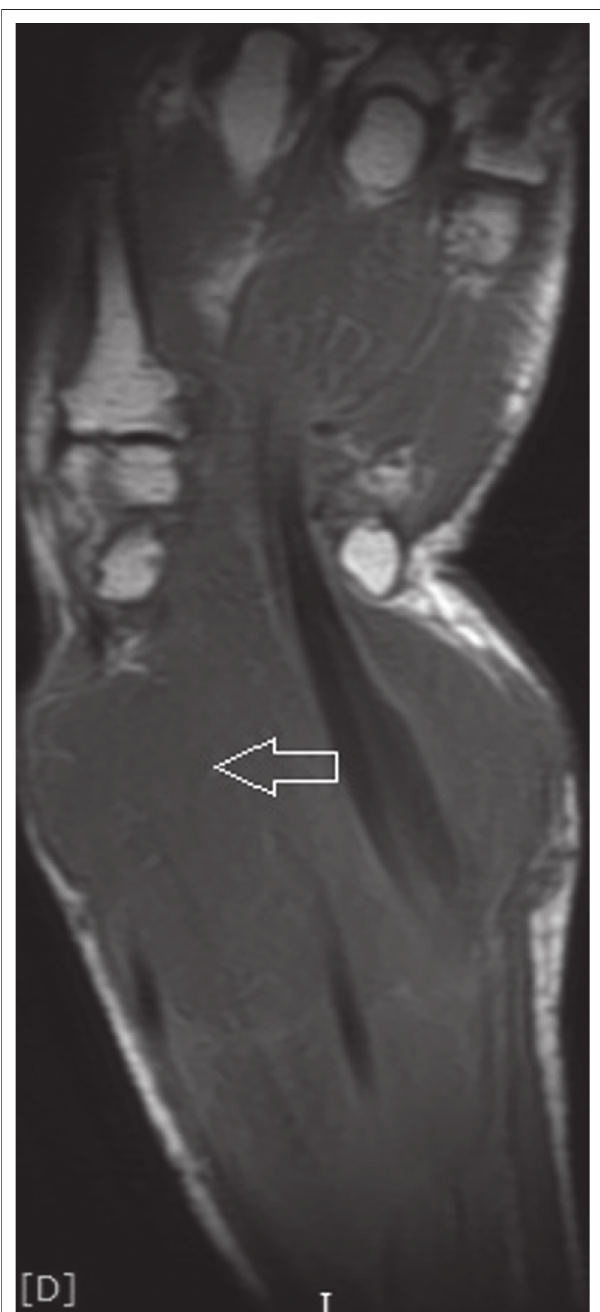
FIGURE 4: Coronal T1-weighted image demonstrates an iso- to hypointense lesion (arrow).